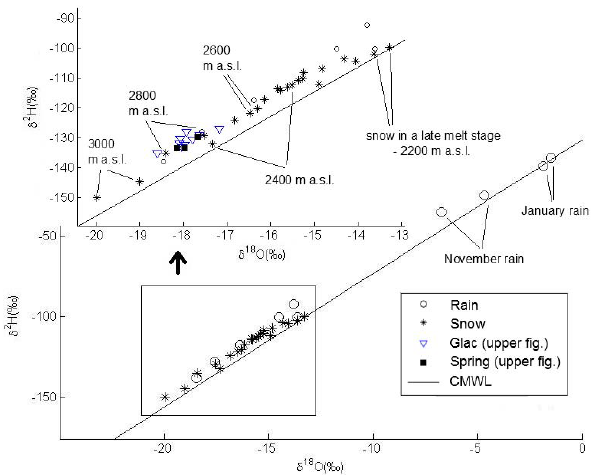
Fig. 7. Isotopic composition in samples of glacier melt, rain, snow and a spring in the study area. The upper diagram magnifies the data which had values within the range of snow samples and in- cludes the nine glacier melt (Glac) samples (blue, open triangles) and the three spring samples (black squares). The altitudes at which snow samples (black stars) were collected are also shown. The samples for which no altitude is shown were collected near the stream gauge (at 2200ma.s.l.). CMWL is a line representing the δ 18 O/ δ 2 H relationship defined as the Chilean Meteoric Water Line ( δ 2 H = 8.3 · δ 18 O + 9.8; Spangenberg et al.,